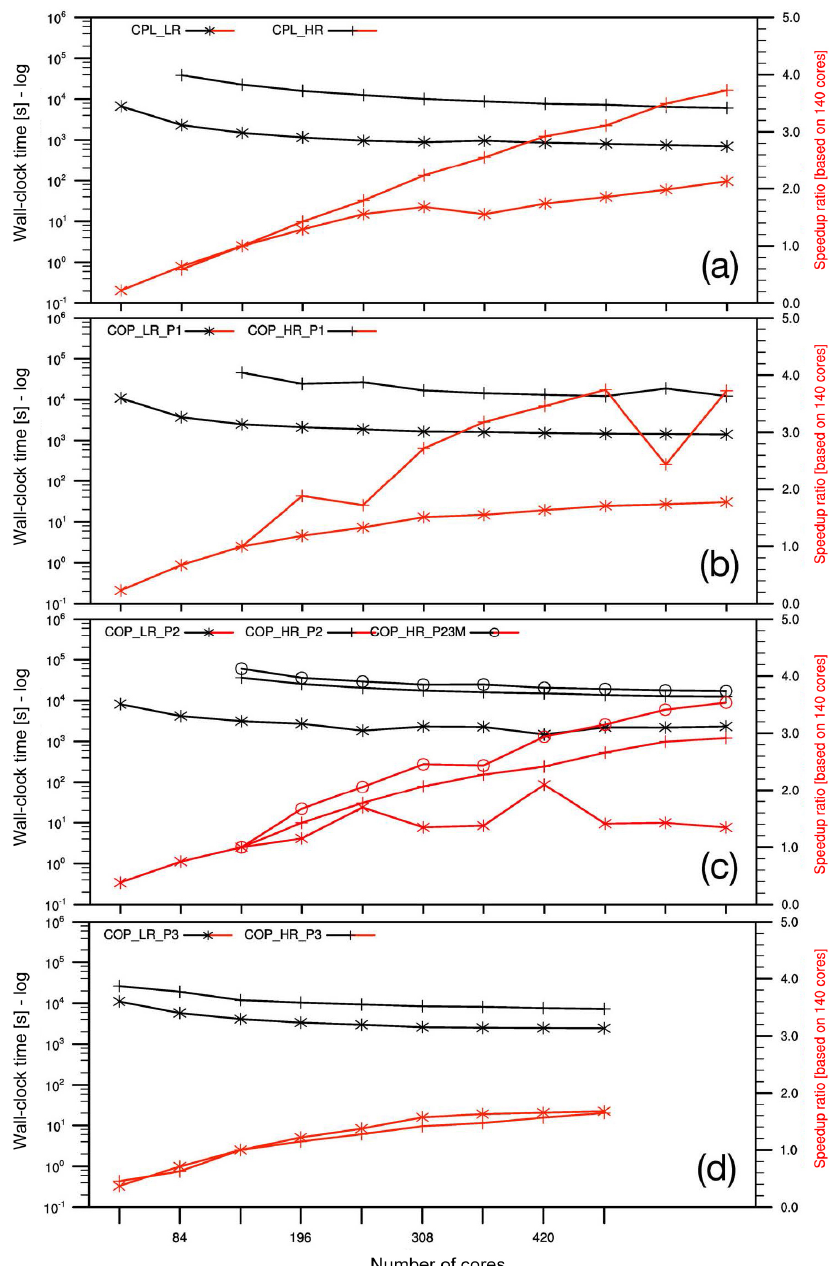
Figure 10. Benchmark results of the (a) CPL simulations, (b) COP simulations with the P1 visualization pipeline, (c) COP simulations with the P2 visualization pipeline and (d) COP simulations with the P3 visualization pipeline. CPL represents the two-component modeling system (ATM and OCN), and COP indicates three-component modeling system (ATM, OCN and co-processing). Note that the HR case requires at least 140 cores to run and the speedup results are given based on 140